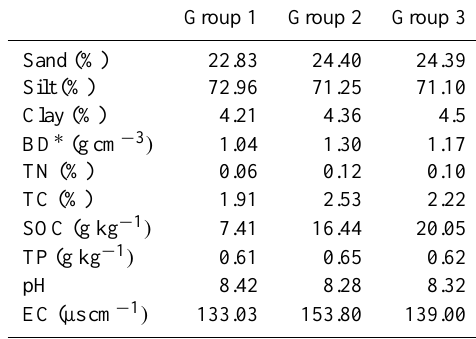
Table 2. Soil properties of the three runoff plot groups.